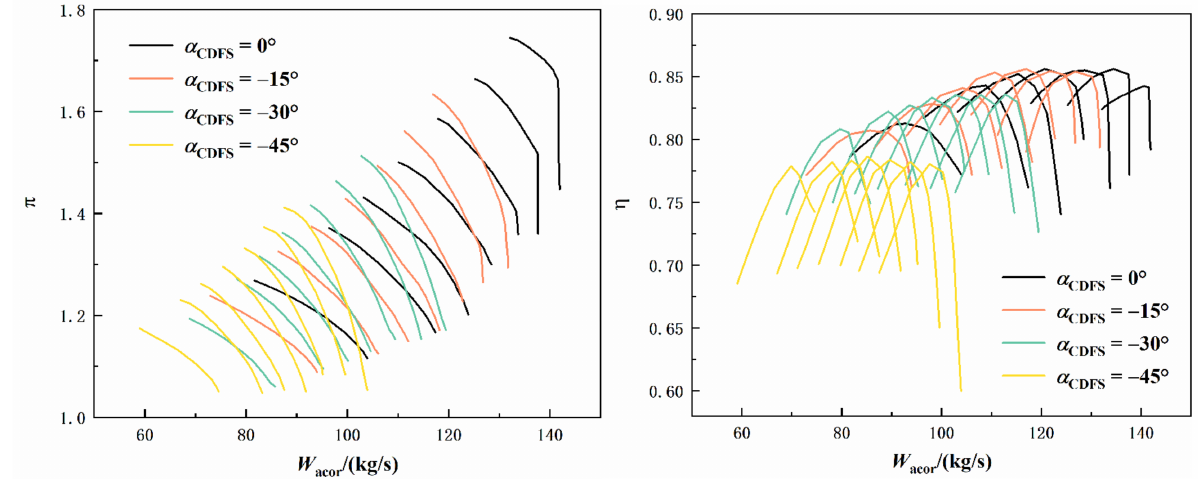
Figure 3. Characteristic maps of the maturely designed